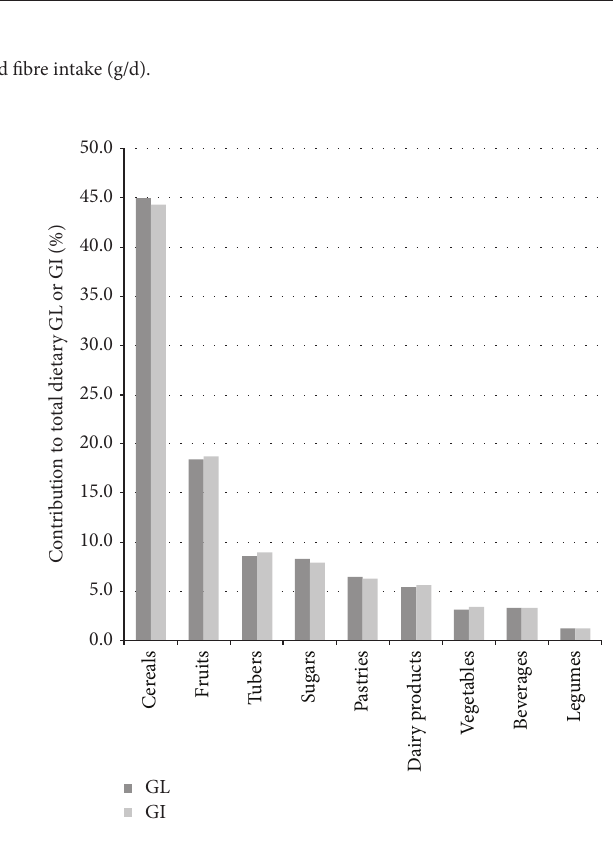
Figure 1: Relative contribution of food groups (%) to total dietary GL and GI in nondiabetic subjects in the PREDIMED study at one year of